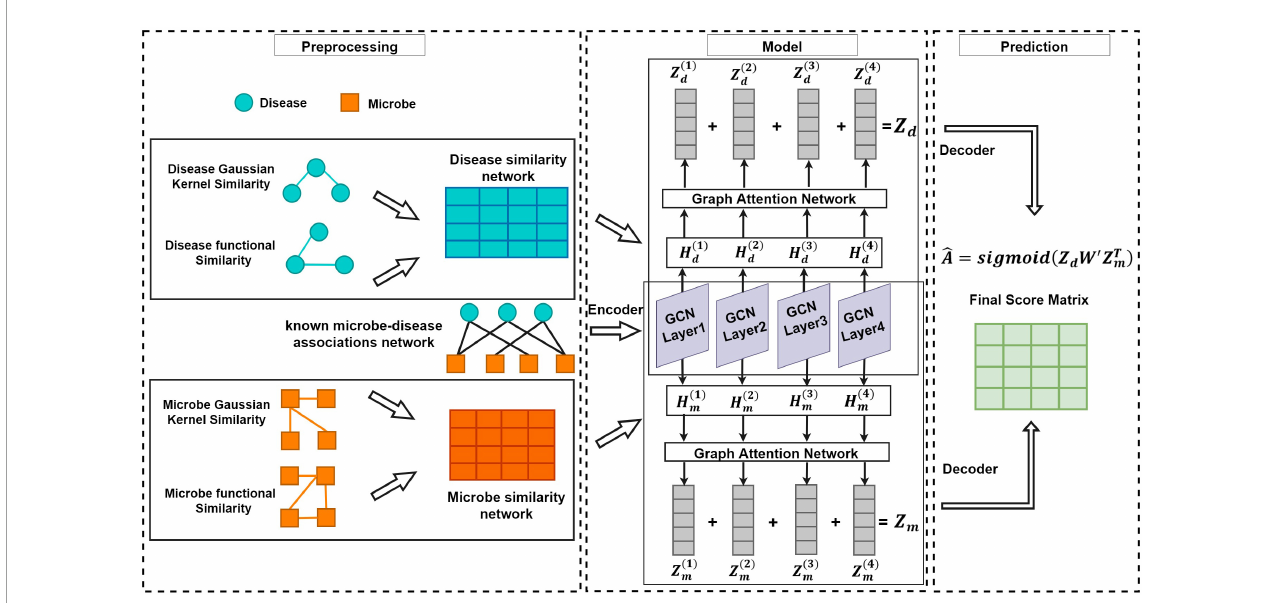
FIGURE1 The flowchart of MDAGCAN for novel microbe-disease association